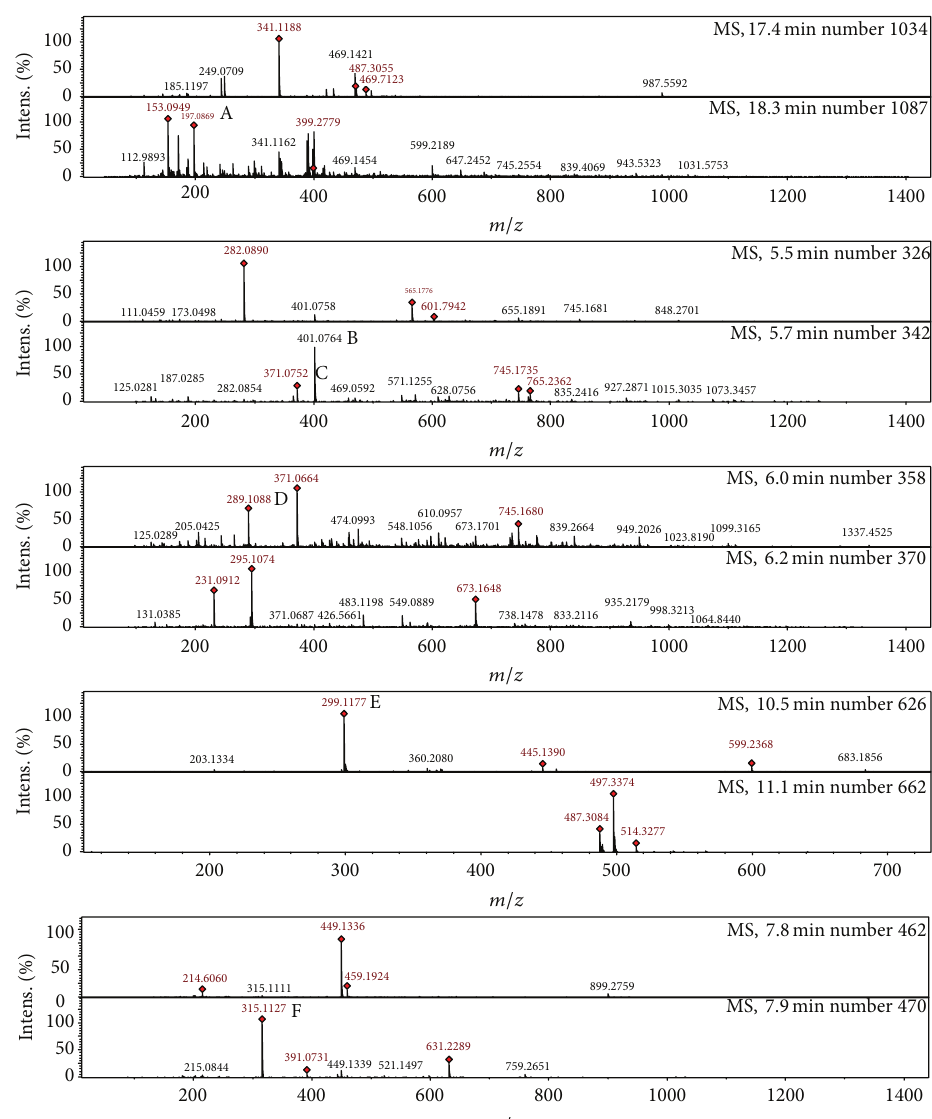
Figure 2: LCMS chromatogram of phenolic acid and flavonoids in the aqueous extract of Nauclea latifolia fruits. (A) Syringic acid, (B) nobiletin, (C) tangeritin, (D) catechin, (E) chrysoeriol, and (F) isorhamnetin.